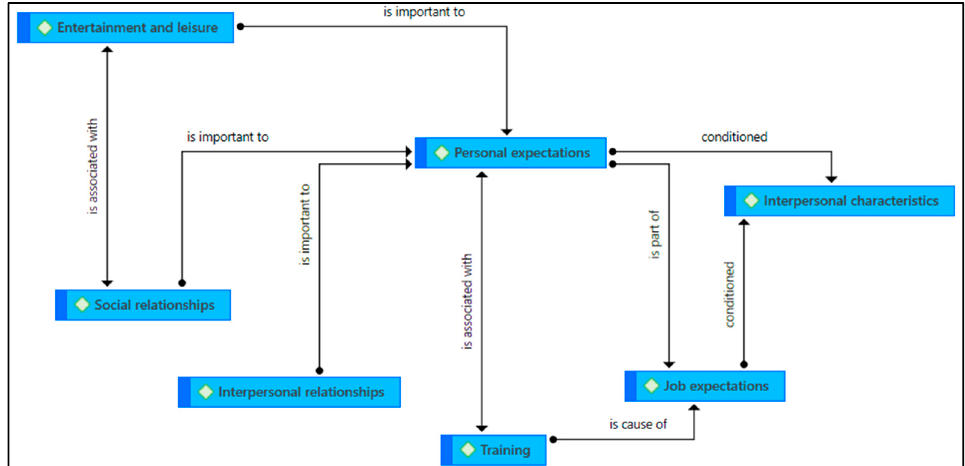
Figure 5. Semantic network of relationships between topics .